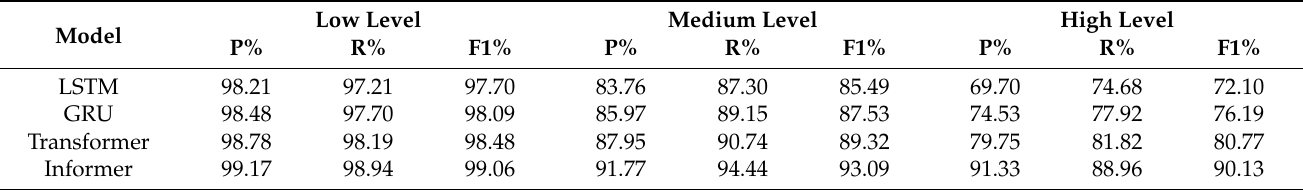
Table 3. Risk level prediction evaluation